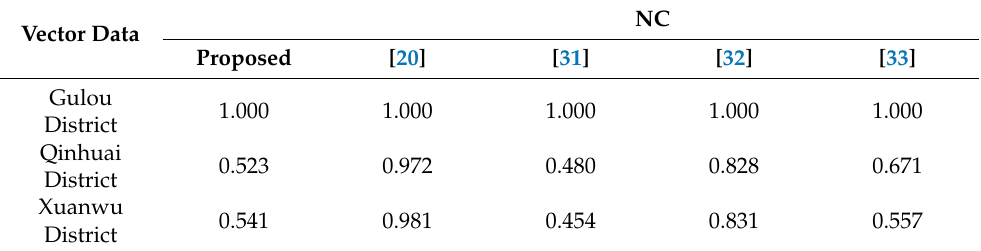
Table 5. Units for magnetic properties.